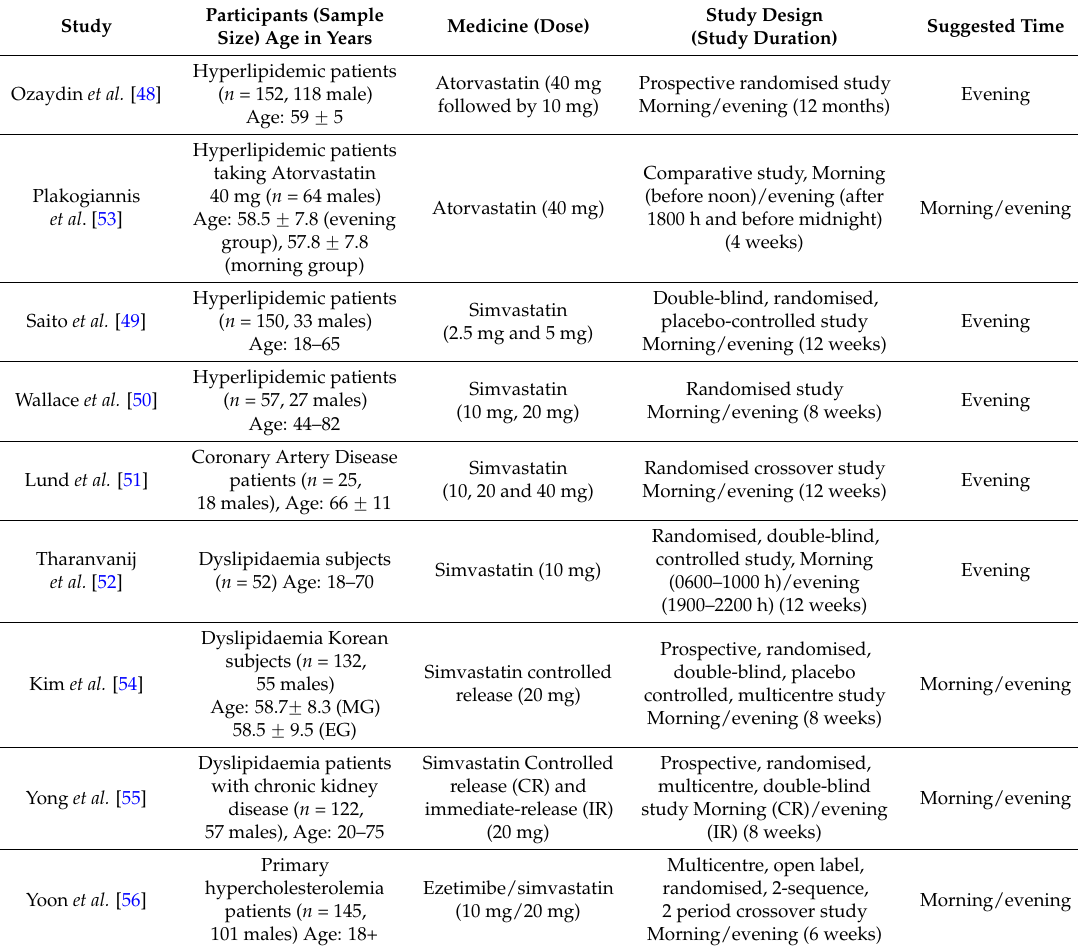
Table 2. Evidence supporting chronotherapy of